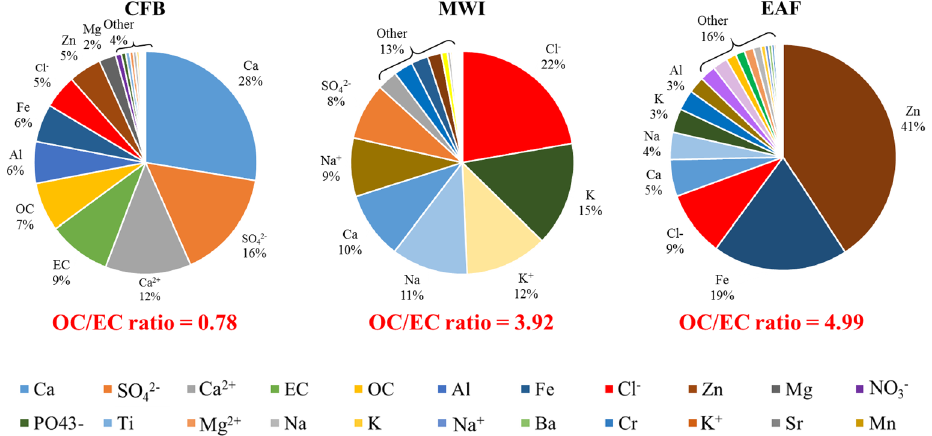
Figure 1. The percentage of chemical species in PM 2.5 measured in stack gases at different facilities.